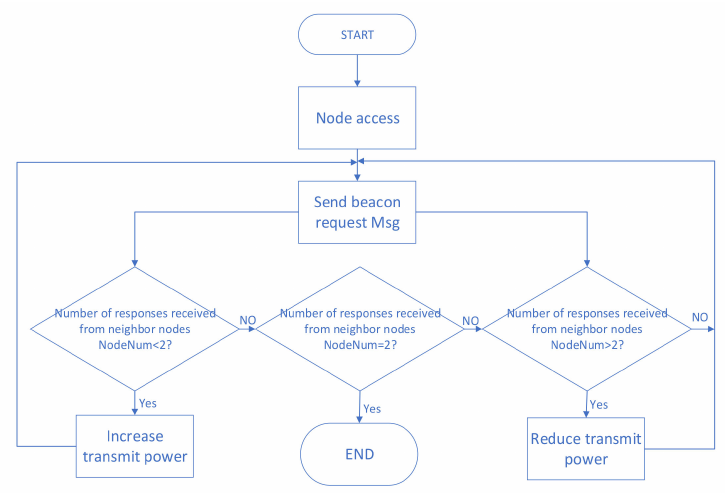
Figure 14. Implementation diagram of power control